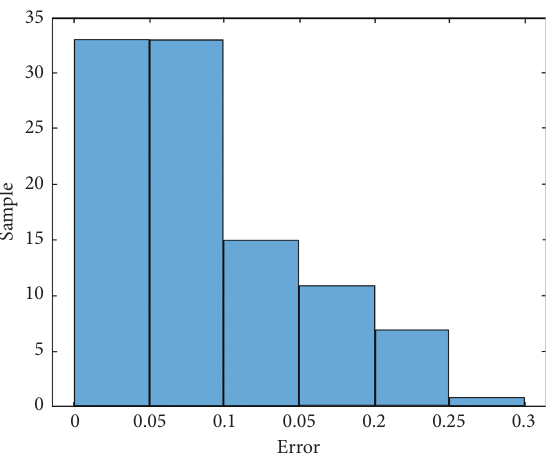
Figure 10: Test error distribution.